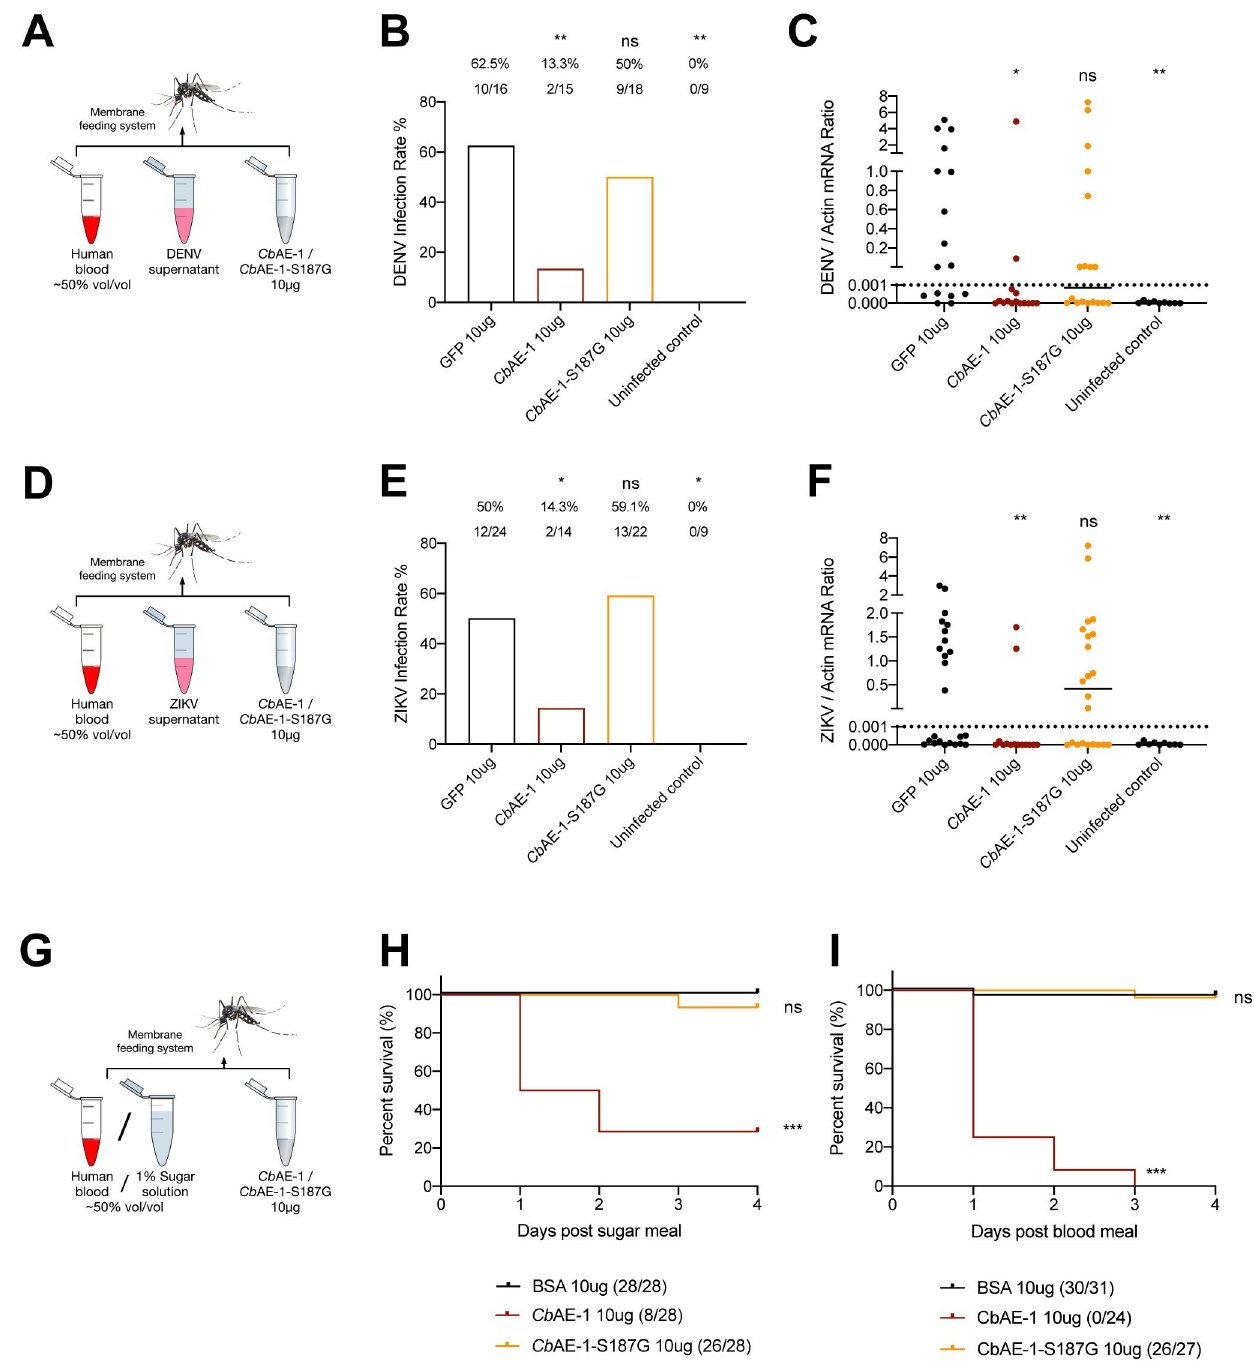
Fig 6. Both the virucidal and entomopathogenic properties of Cb AE-1 in mosquitoes are dependent on its lipase activity. (A-F) The virucidal activity of Cb AE-1 against DENV (A-C) and ZIKV (D-F) infection in A . aegypti is dependent on its lipase activity. (A, D) Schematic representation of the study design. A mixture containing human blood (50% v/v), 10 μ g Cb AE-1 or Cb AE-1-S187G, and supernatant from DENV- (A) or ZIKV- (D) infected Vero cells was used to feed antibiotic-treated A . aegypti via a membrane blood feeding system. Mosquito infectivity was determined by RT–qPCR at 8 days post blood meal. The final DENV or ZIKV titre was 1 × 10 5 PFU/mL for oral infection. (B, E) Mosquito infection rate after oral supplementation of Cb AE-1 or Cb AE- 1-S187G with DENV (B) or ZIKV (E). (C, F) Mosquito viral load after oral supplementation of Cb AE-1 or Cb AE-1-S187G with DENV (C) or ZIKV (F). (G-I) The entomopathogenic activity of Cb AE-1 in A . aegypti is dependent on its lipase activity. (G) Schematic representation of the study design. A mixture containing 1% sugar solution (H) or human blood (I) (50% v/v) and 10 μ g Cb AE-1 or Cb AE-1-S187G (50% v/v) was used to feed antibiotic-treated A . aegypti via a membrane blood feeding system. Mosquito mortality was observed over 4 days. (B, C, E, F, H, I) The number of infected mosquitoes relative to